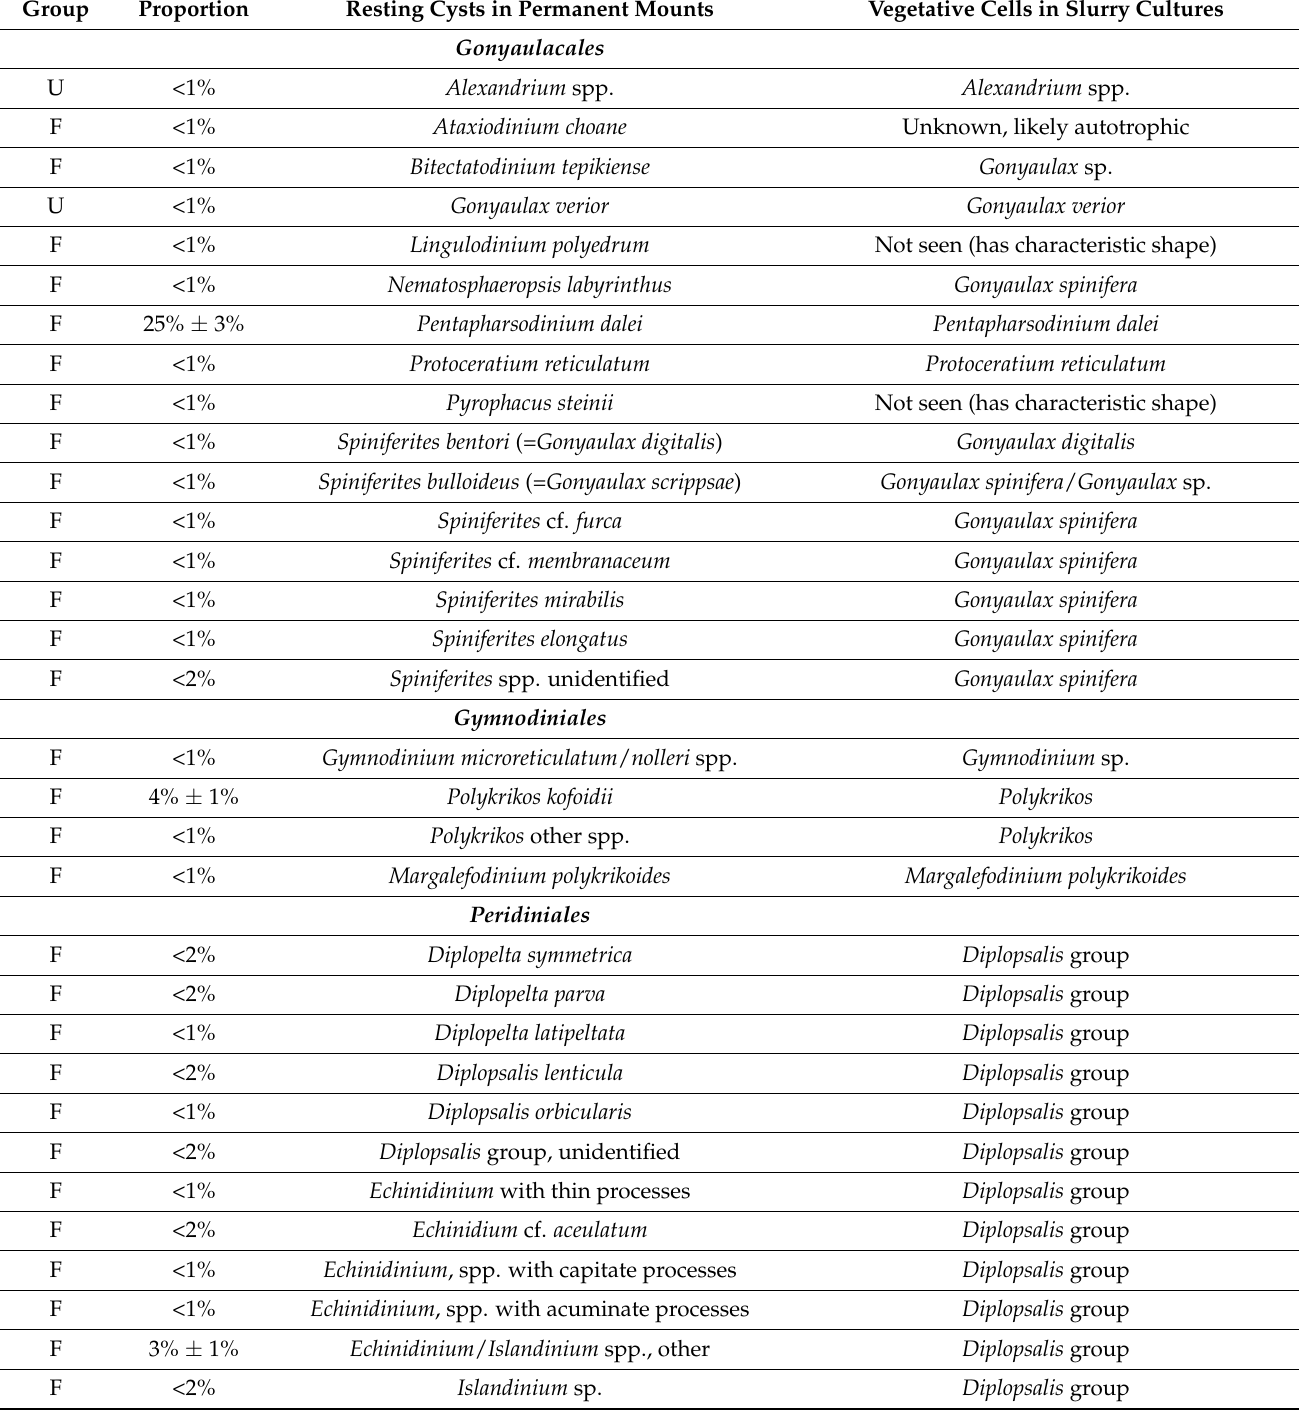
Table 1. Resting cysts recorded in permanent cyst mounts and corresponding vegetative cells found in slurry cultures. Groups: U = unfossilizable, F = fossilizable, G = round gray smooth ( Kryptoperidinium sp.?). The proportion is the percentage ( ± standard deviation) of the cyst assembly in the original concentrated sediment at